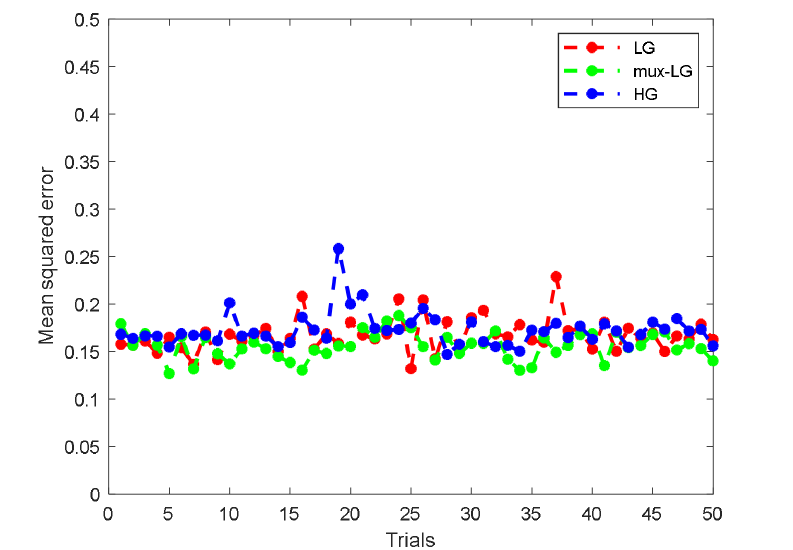
Figure 16. MSE of estimating the SJR over fifty independent runs for: LG, Mux-LG, and HG